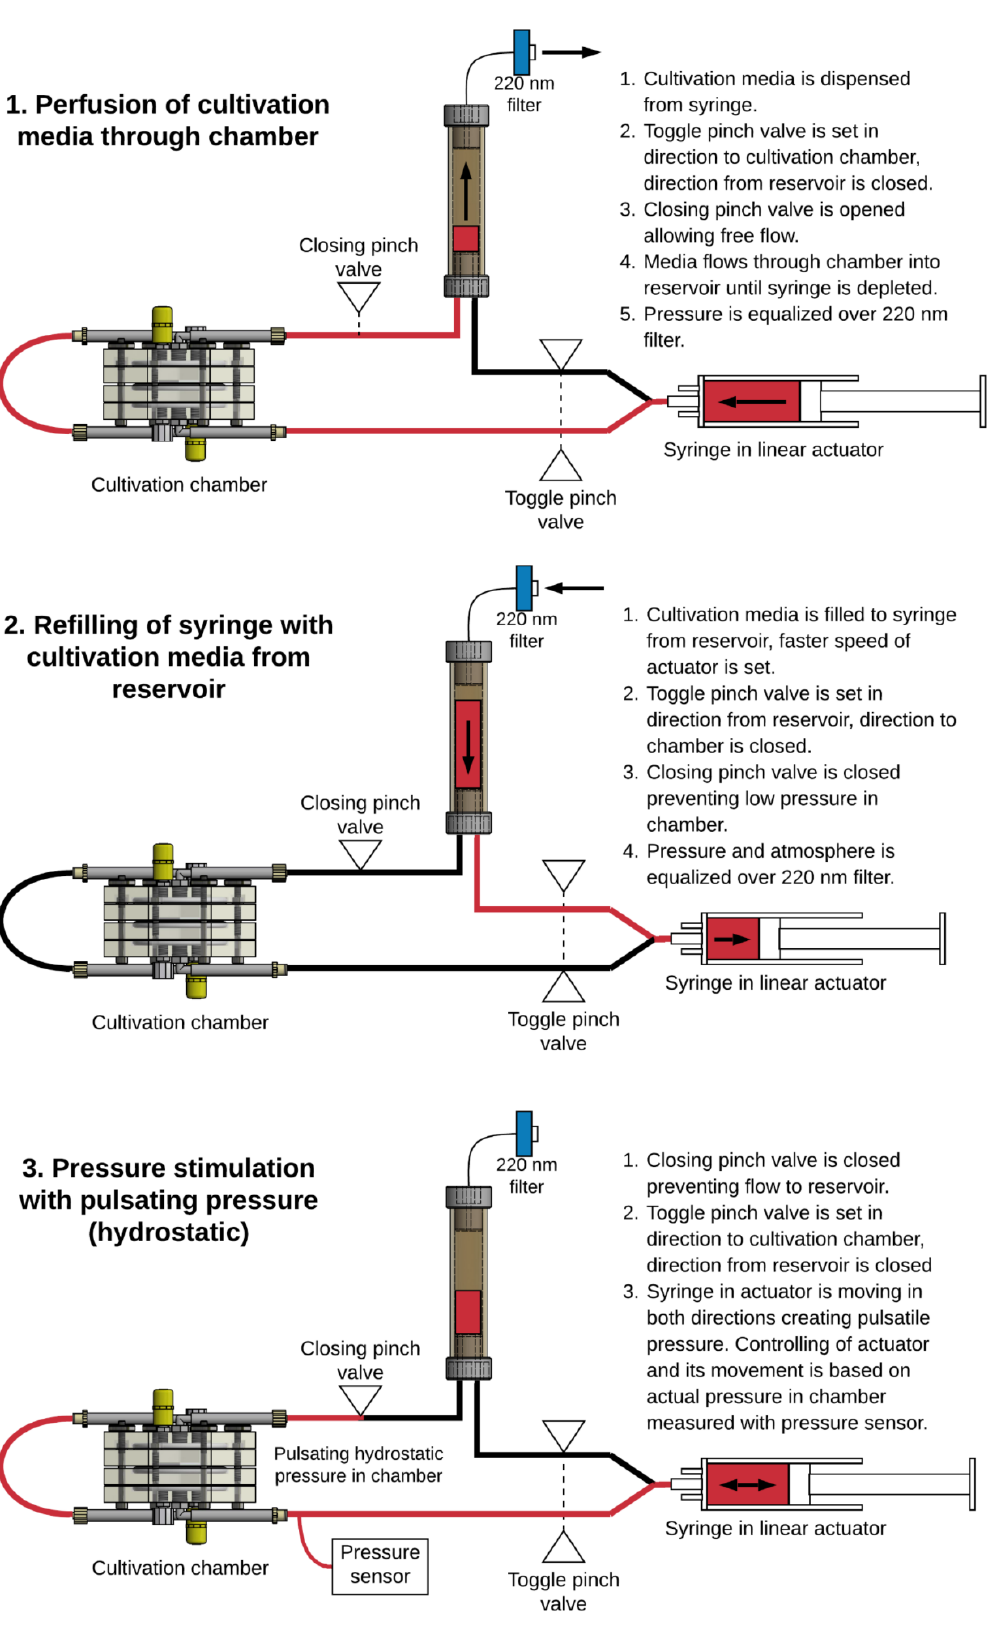
Figure 4. Schematic setup of the perfusion / stimulation circuit with a connected chamber. Three modes of operation used in the cultivation process are shown.